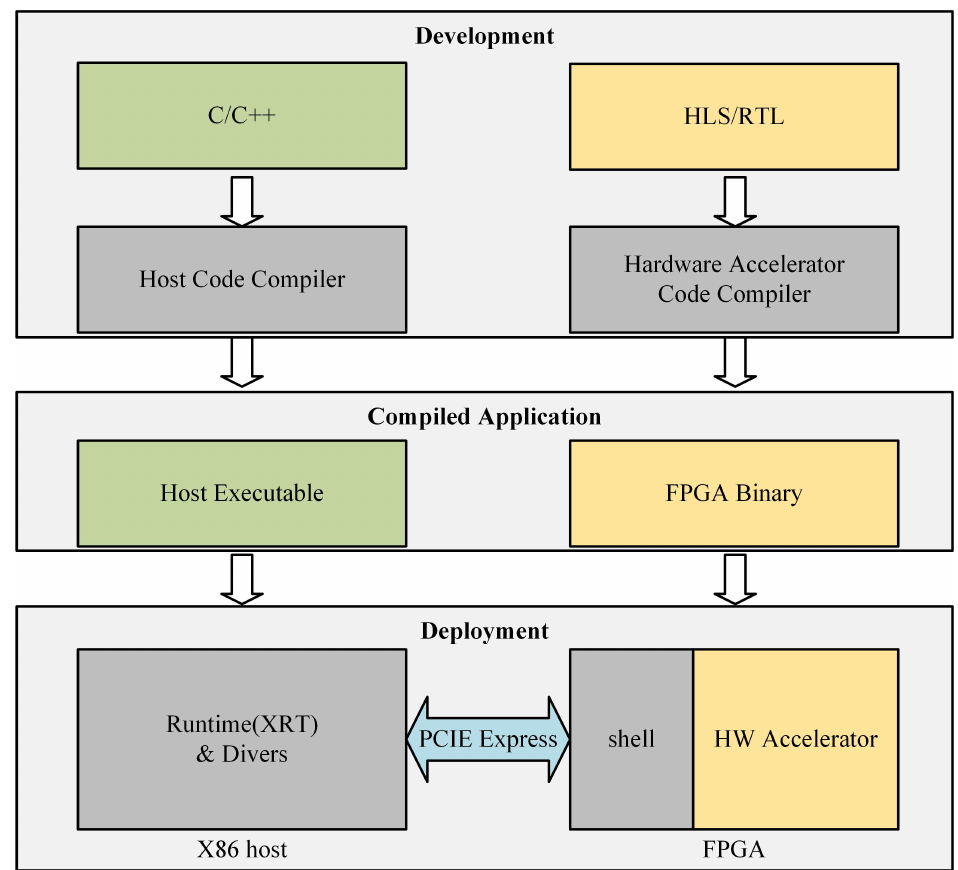
Figure 2. Vitis programming environment